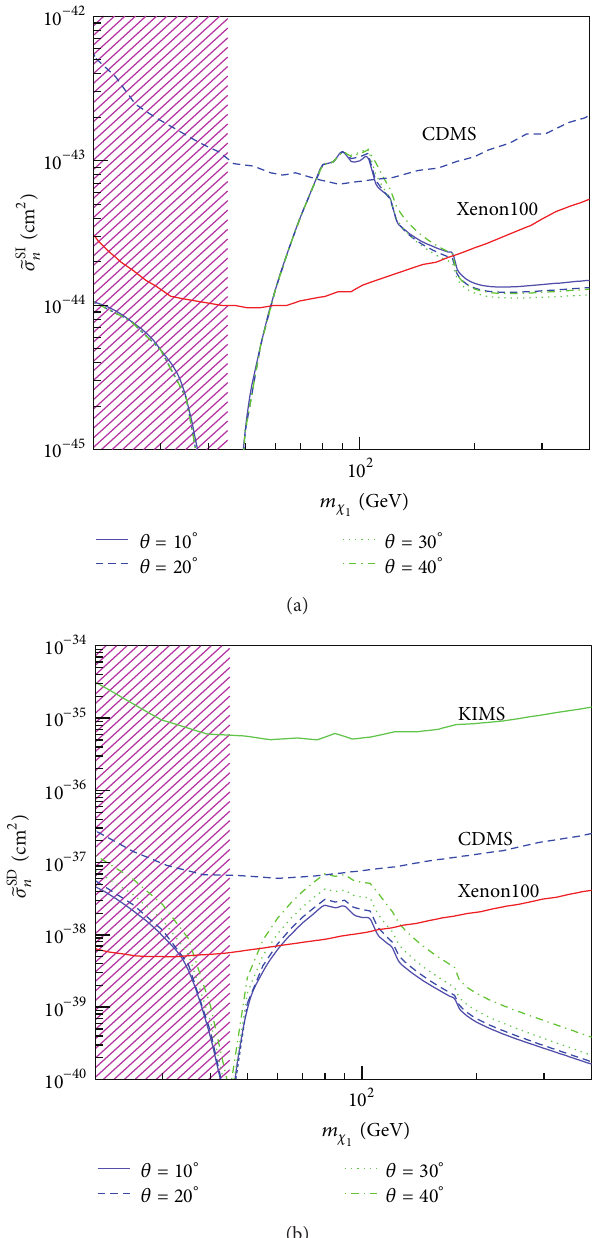
Figure 2: (a) Rescaled spin-independent cross-section ̃𝜎 SI 𝑛 as a function of 𝜒 1 mass for rescaling factor 𝑟 𝜌 = 𝑟 Ω and the same 𝜃 values as in Figure 1, compared to upper limits from CDMS [109] and Xenon100 [110]. (b) The corresponding spin-dependent cross- section ̃𝜎 SD 𝑛 , compared to upper limits from KIMS [111], CDMS [112], and Xenon10 [113]. Plots from [10].